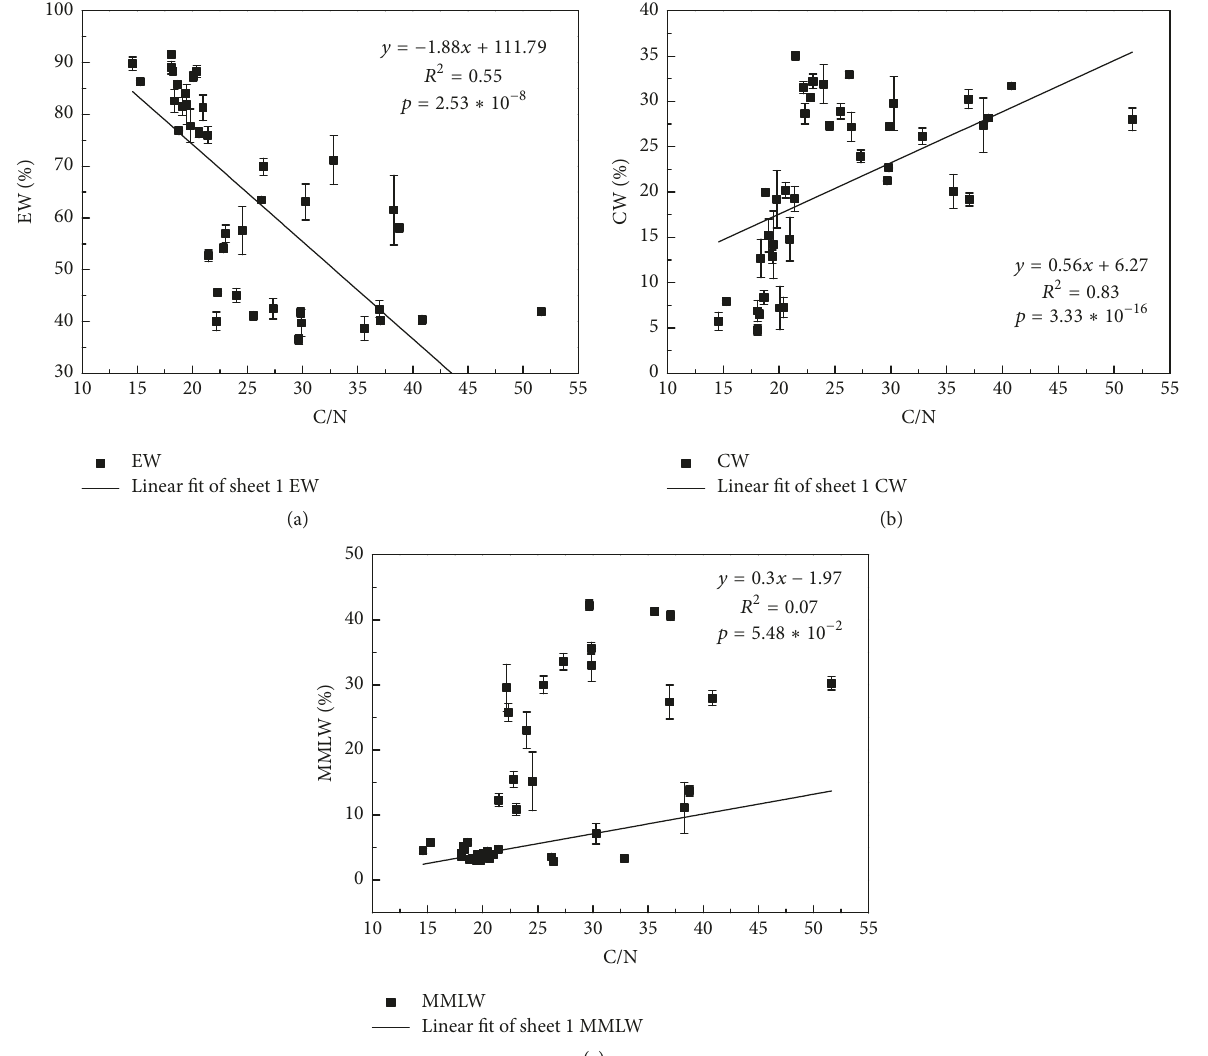
Figure 4: (a) Correlation between the percentage of EW and C/N during the composting process in all five composting treatments, (b) correlation between the percentage of CW and C/N during the composting process in all five composting treatments, and (c) correlation between the percentage of MMLW and C/N during the composting process in all five composting treatments.